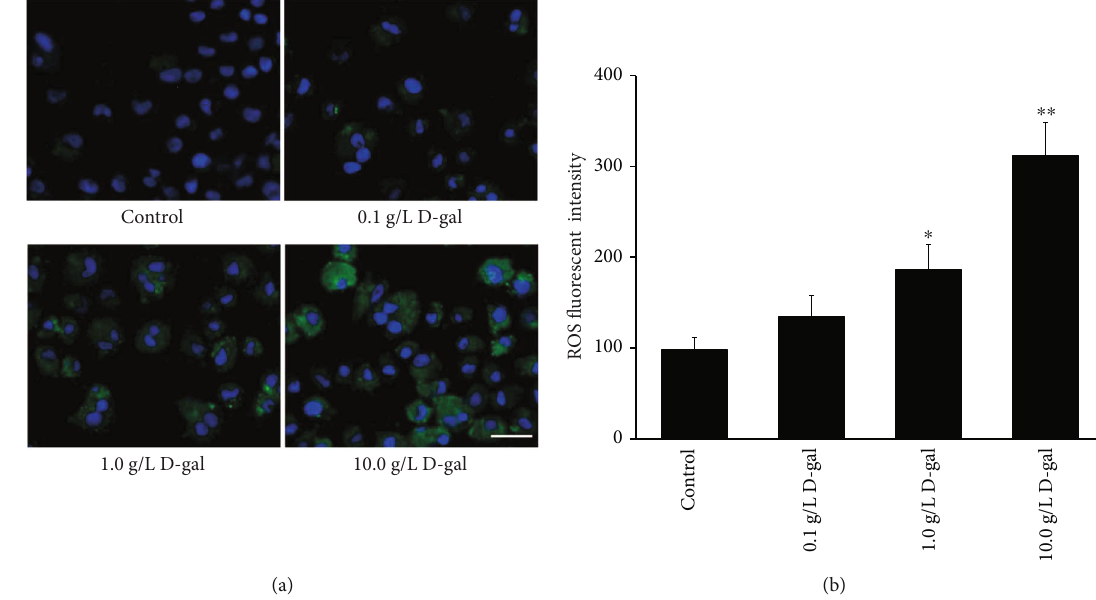
Figure 3: E ff ects of D-gal on ROS generation in J774A.1 cell. (a) ROS staining. In the 1.0 and 10.0g/L D-gal groups, increased ROS-stained cells were observed under a fl uorescence microscope compared with that in the control group. Green, ROS staining; blue, Hoechst 33342 staining. Scale bar = 25 μ m . (b) ROS level quanti fi cation. The DCFH fl uorescence intensity in the 1.0 and 10.0g/L D-gal groups was signi fi cantly increased compared that of the with the control group ( ∗ P < 0 : 05 , ∗∗ P < 0 : 01 ; n = 3